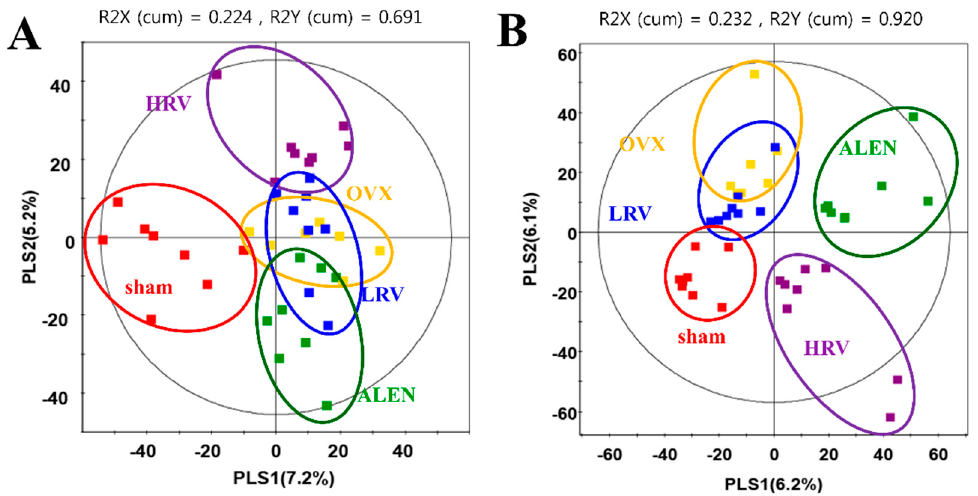
Figure 3. Partial least-squares discriminant analysis (PLS-DA) score plots derived from the GC-TOF-MS ( A ) and UPLC-Q-TOF-MS ( B ) data of ovariectomized rat groups. ( ■ ; sham-operated control, ■ ; ovariectomized rat without treatment, ■ ; ovariectomized rat treated with low-dose RC vinegar, ■ ; ovariectomized rat treated with high-dose RC vinegar, ■ ; ovariectomized rat treated with alendronate). Table 2. Discriminant plasma metabolites identified using GC-TOF-MS in different rat groups. No.